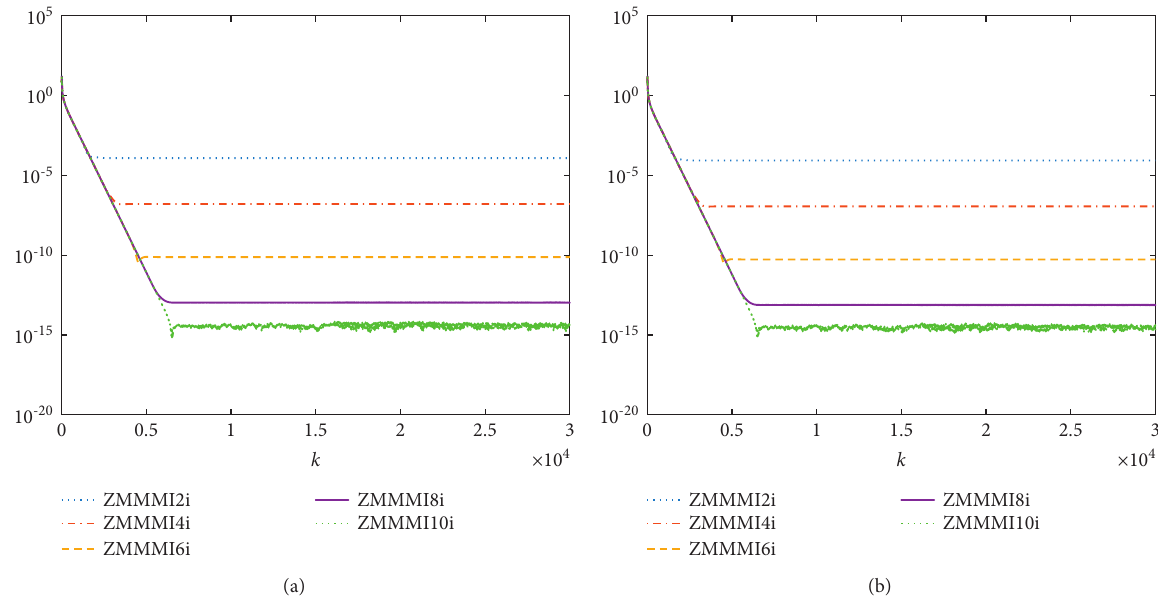
Figure 1: Residual error trajectories synthesized by five ZMMMI algorithms for example 1 (with ϵ � 0 . 001 s and c � 5 . 0). (a) Trajectories of A − I ‖ ‖ X . (b) Trajectories of ‖ X k + k + 1 k + 1 F